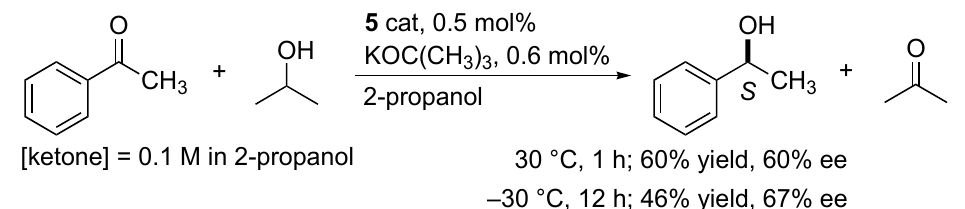
7 of 12 Figure 2. Selected 1 H NMR spectrum of a streoisomeric mixture of hydridoiridium generated from 6 with